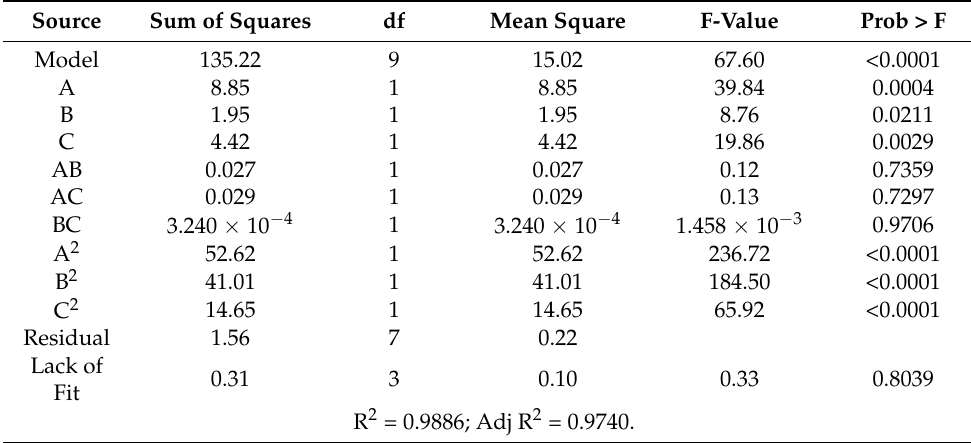
Table 4. ANOVA for Response Surface Quadratic Model.